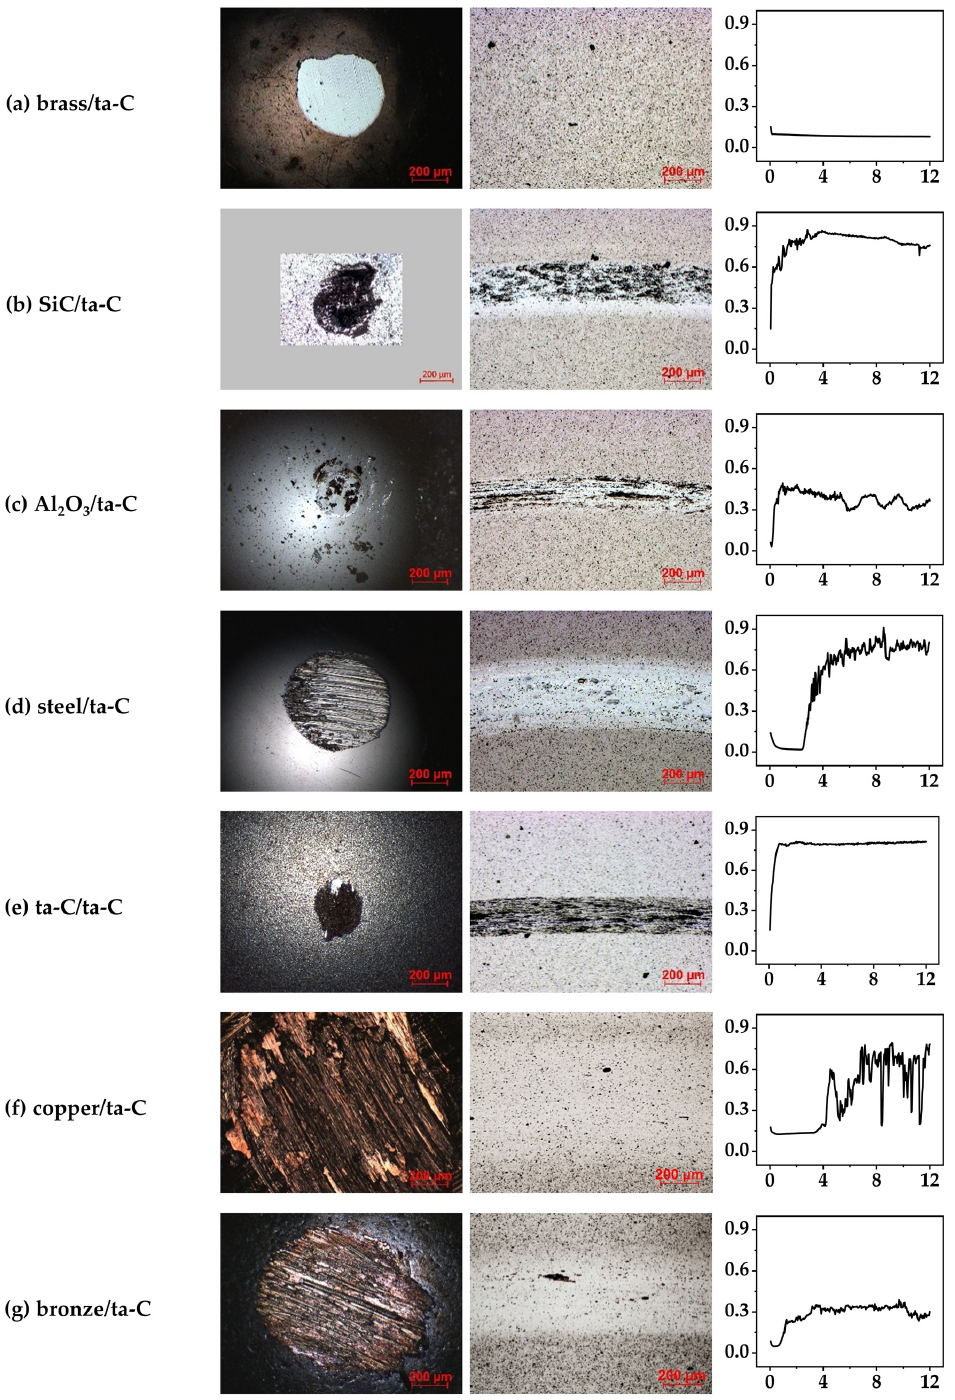
Figure 1. Light microscope images of wear on counterbody ( left ) and disc ( middle ) are shown for various counterbodies: ( a – g ) all paired with a ta-C disc under high vacuum. Friction coefficient diagrams are shown ( right ), with friction coefficient on the y -axis and sliding distance/m on the x -axis. Third- body films are visible in ( b , c , e ), attributed to transfer of carbon material from the coated disc to the counterbody. Pressures/mbar: brass/ta-C: 1.1 × 10 − 7 ; SiC/ta-C: 6.7 × 10 − 7 ; Al 2 O 3 /ta-C: 3.3 × 10 − 7 ; steel/ta-C: 2.0 × 10 − 7 ; ta-C/ta-C: 4.7 × 10 − 7 ; copper/ta-C: 3.6 × 10 − 7 ; bronze/ta-C: 3.6 × 10 − 7